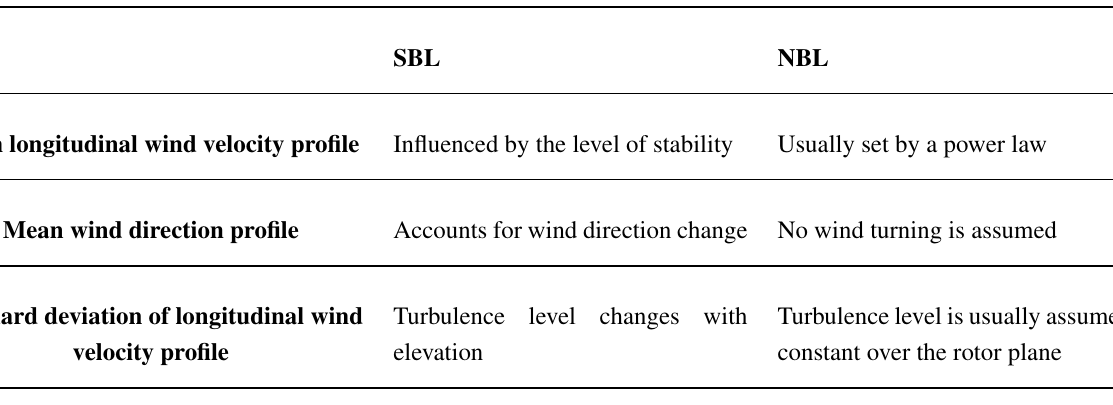
Table 6. Summary of the differences in SBL and NBL wind